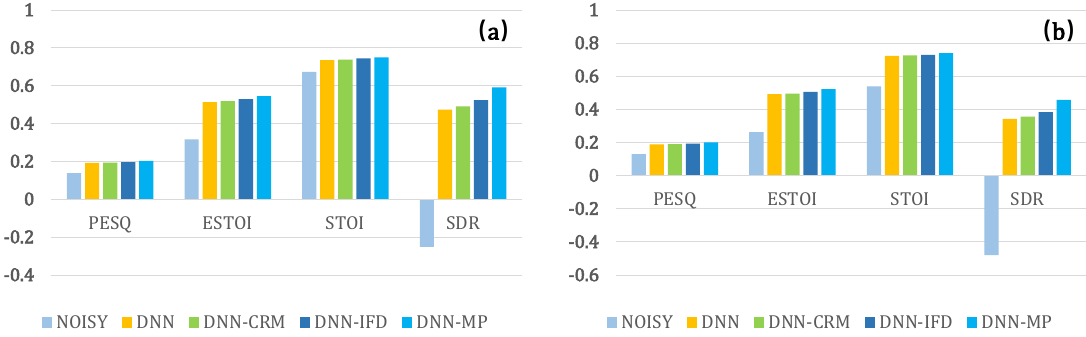
Figure 5. Performance averaged on ( a ) all SNR levels for factory1 noise, and ( b ) all noise at − 5 dB SNR